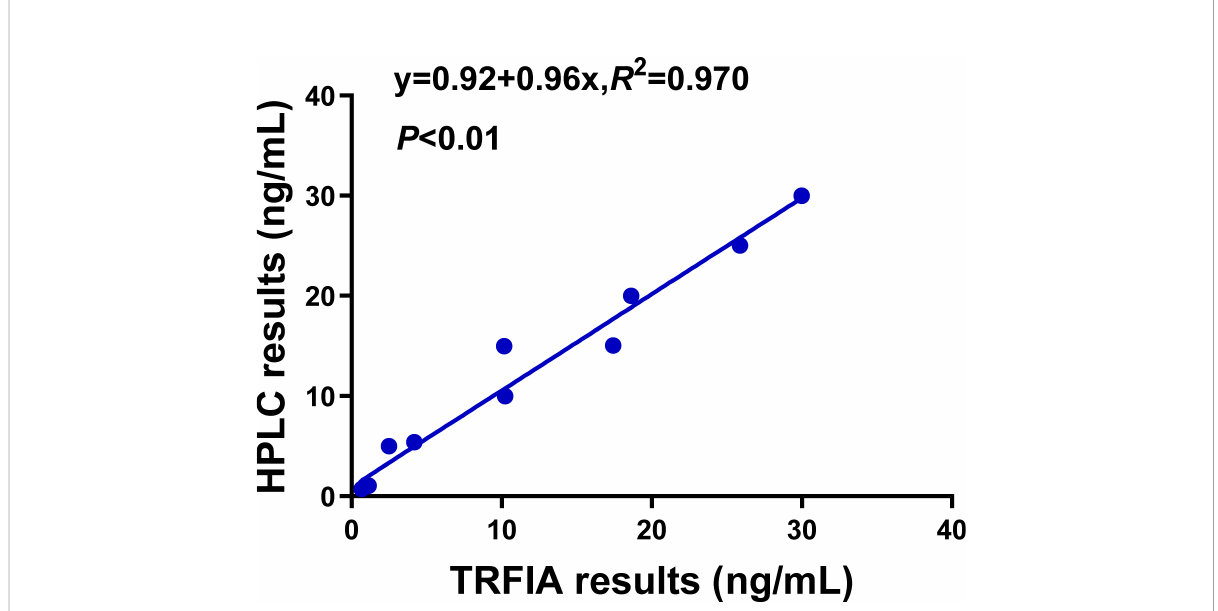
FIGURE 4 Correlation between TRFIA and HPLC for the concentrations of OA in shell fi sh